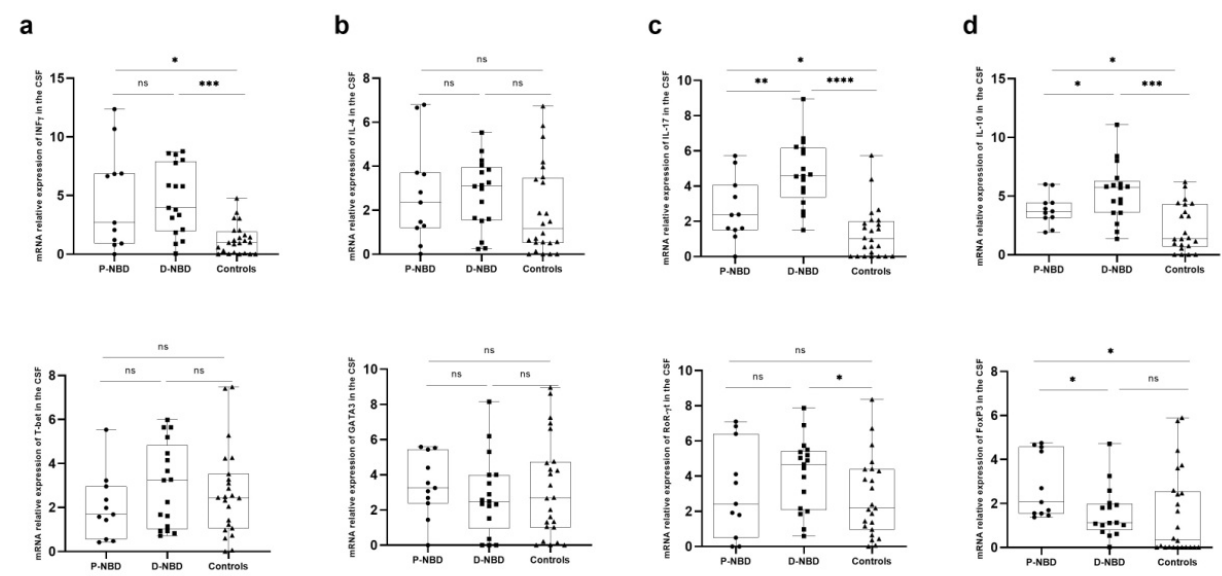
Figure 3. Boxplots representation of CSF cells’ Th1, Th2, Th17 and Treg-related gene expression: ( a ) Representative boxplots of INF- γ and T-bet expression in the CSF of patients and NIND; ( b ) Representative boxplots of IL-4 and GATA3 expression in the CSF of patients and NIND; ( c ) Representative boxplots of IL-17 and RoR- γ t expression in the CSF of patients and NIND; ( d ) Representative boxplots of IL-10 and Foxp3 expression in the CSF of patients and NIND. Statistical significance between the two groups was assessed using the Wilcoxon–Mann–Whitney test ns = non significant, * p ≤ 0.05, ** p < 0.01, *** p < 0.001,**** p < 0.0001.